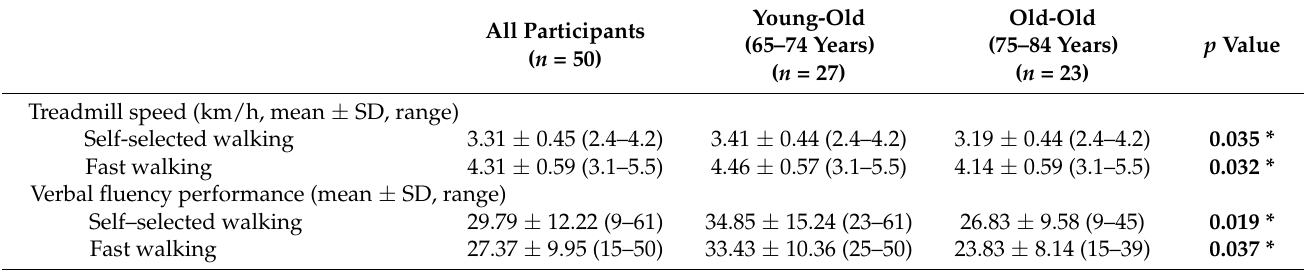
Table 2. Treadmill speed and verbal fluency performance during dual-task walking in the young-old and old-old. All Participants ( n = 50)